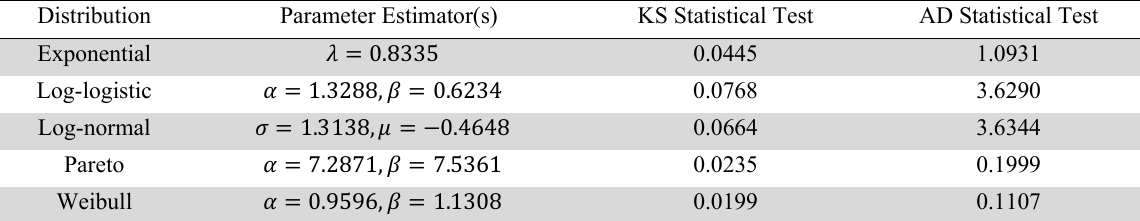
Parameter Estimators and Statistical Values of KS and AD Statistical Tests of Each Theoretical Distribution Distribution Parameter